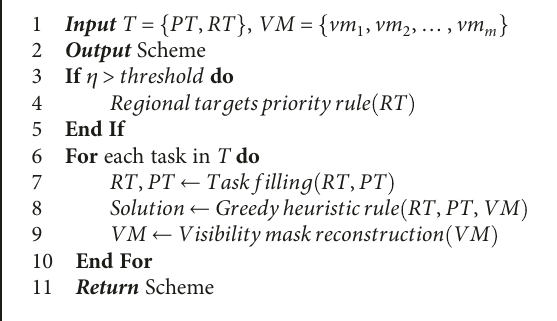
Algorithm 1: Downlink schedule algorithm